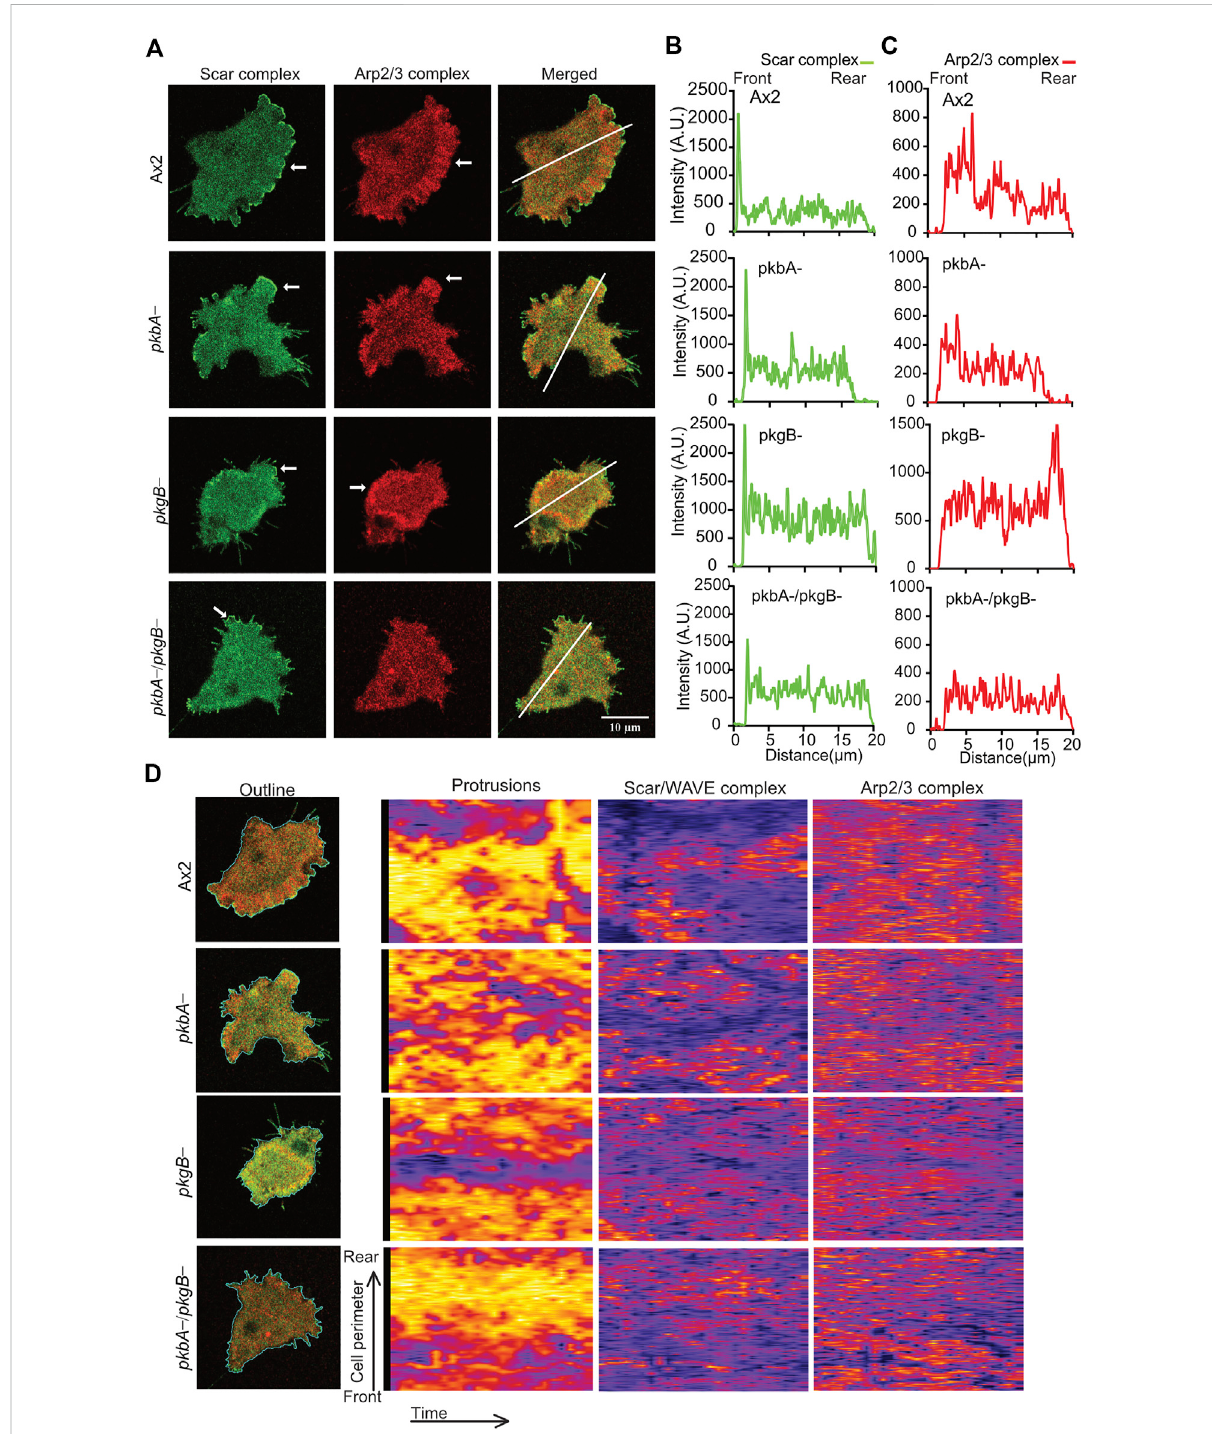
FIGURE 4 TherecruitmentofScar/WAVEandArp2/3complexesinAx2andmutantcells. (A) SubcellularlocalizationoftheScar/WAVEandtheArp2/3complexesin pseudopods. Ax2, pkbA -, pkgB - and pkbA-/pkgB - cells were labelled with HSPC300-eGFP (Scar/WAVE complex) and mRFPmars2-ArpC4 (Arp2/3 complex) andallowedtomigrateunderagarosefollowingafolategradientandimagedbyAiryScanconfocalmicroscopyataframeintervalof3 s(1f/3 s).TheScar/WAVE complexislocalizedtoprotrusionsofpseudopodiaofallcelltypes(arrows,panel1).TheArp2/3complexisenrichedinthepseudopodiaofAx2and pkbA - cells,inthecellbodyof pkgB -,butislackinginthe pkbA-/pkgB -cells(arrows,panel2). (B,C) Quanti fi cationoftheScar/WAVEandArp2/3complex fl orescence intensitiesalongtheindicatedlineacrossthecell(panel3ofA). (D) QuantitativeassessmentoftheScar/WAVEandArp2/3complexrecruitmentincells.Panel1; showstheoutlineofcellsusedforthegenerationofkymographsusingImageJ.Panel2representsprotrusions,panel3;theScar/WAVEcomplexandpanel4; the Arp2/3 complex. Images are representative of ≥ 10 cells from 3 independent